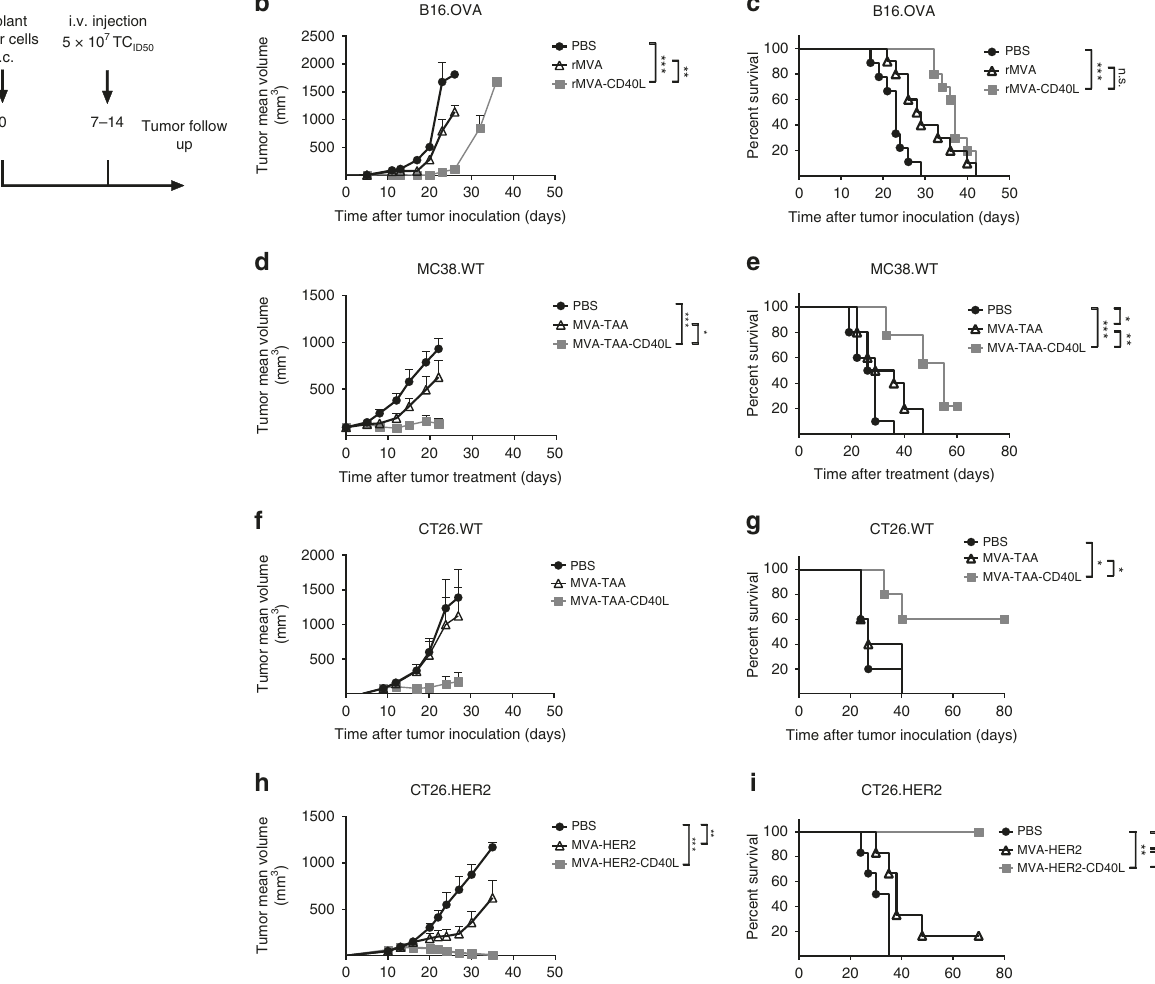
(Fig. 2h). Consistently, OVA 257 – 264 -speci fi c CD8 + T cell (T eff ) to